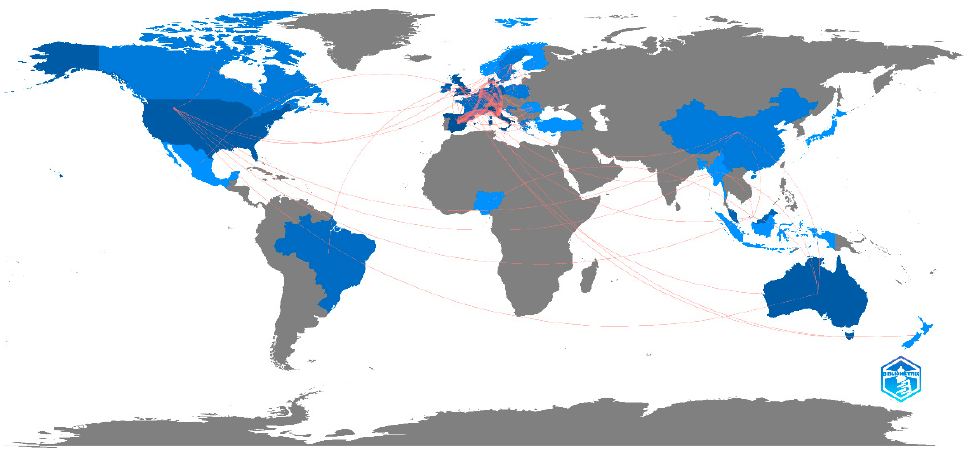
Figure 5. Country collaboration map.